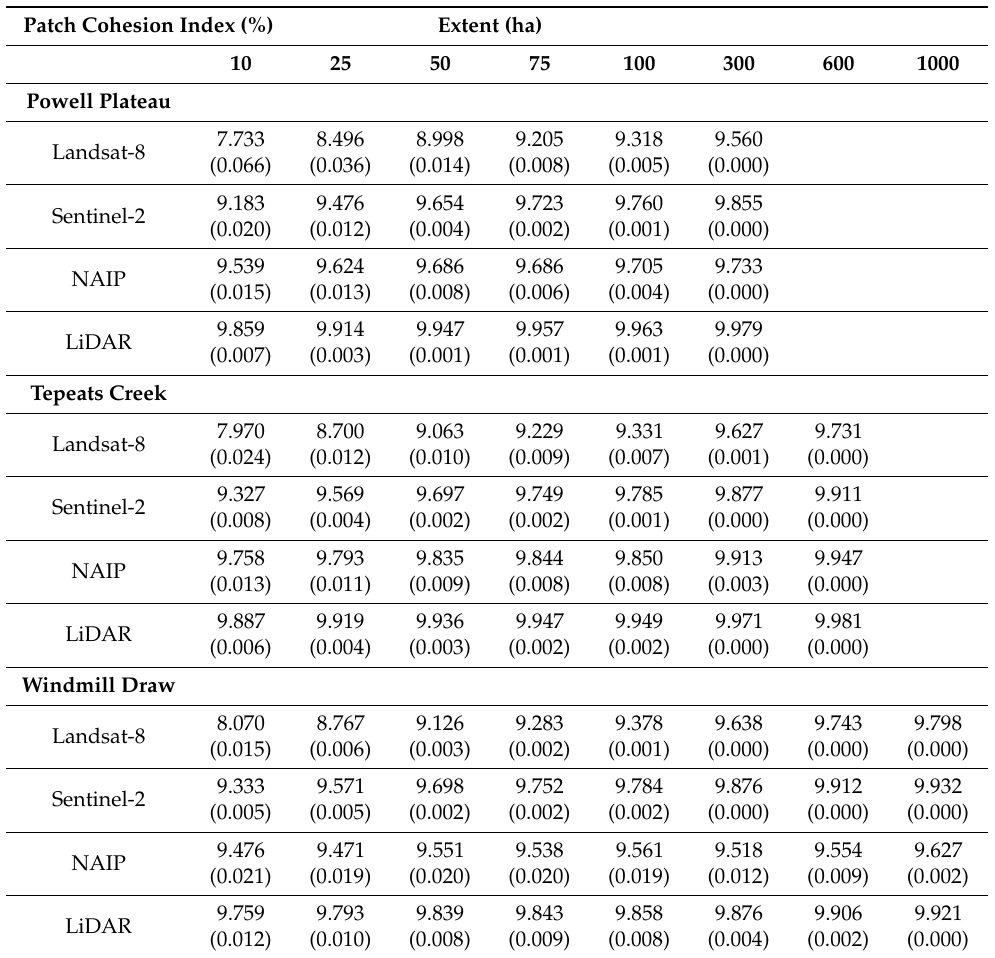
Table 6. Patch cohesion (PC) index measuring the physical connectedness of patches of canopy cover for each landscape and data product (Landsat-8 30 m, Sentinel-2 10 m, NAIP 1 m, LiDAR 1 m), and across spatial extents. Mean values and standard error (SE) are